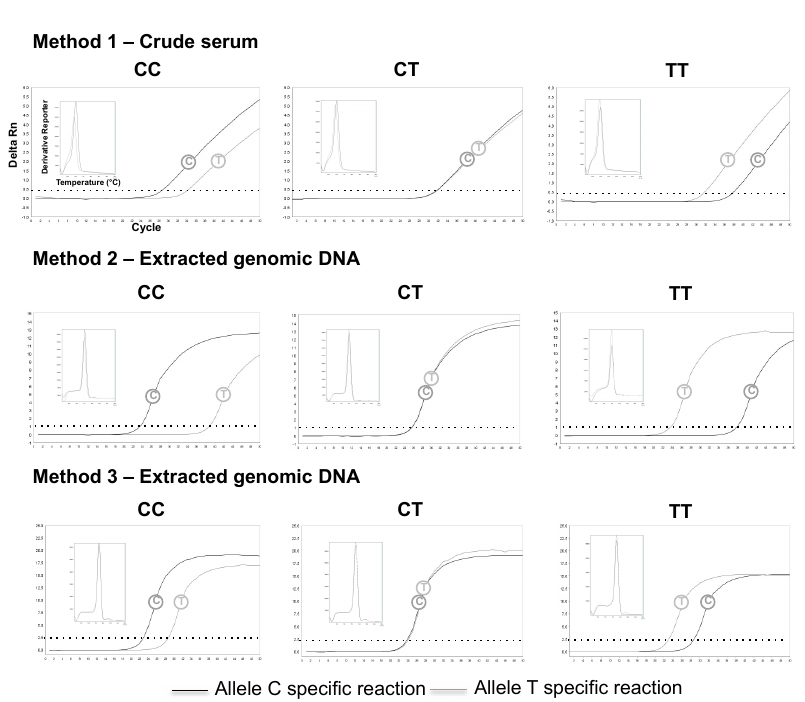
Figure 5. Representative rs4779584 genotyping using method 1 (2 μ L of crude serum separated 4 h after the capillary blood collection), 2 and 3.